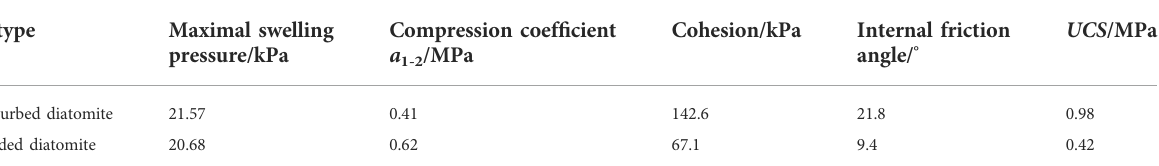
TABLE 3 Engineering properties of remolded and undisturbed diatomite.